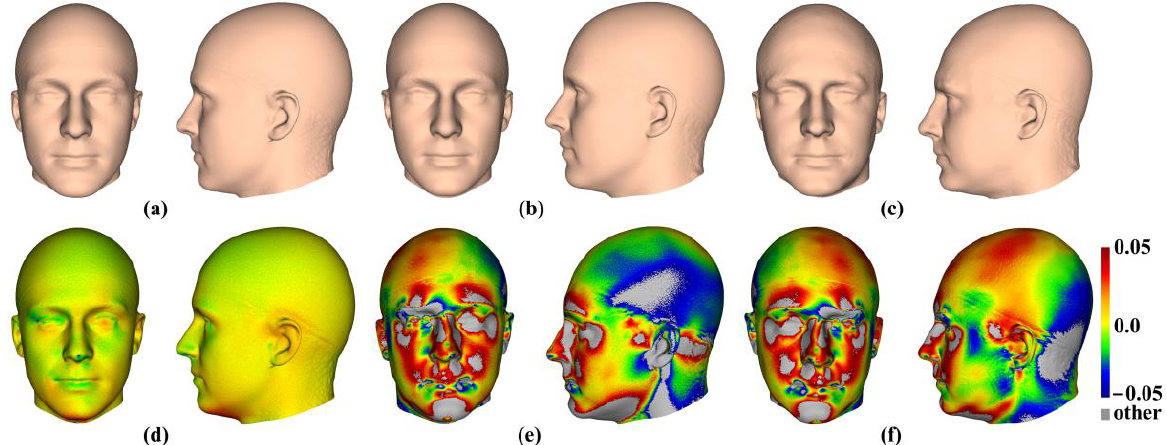
Figure 23. ( a ) Mean head surface estimated by warping the template surface to the mean configuration of landmarks and 1000 semilandmarks from sliding TPS. ( b ) Mean head surface estimated by warping the template surface to the mean landmark configuration. ( c ) Mean head surface estimated by warping the surface of the head with minimum Procrustes distance from the mean to the mean landmark configuration. ( d ) Colour map between surfaces a (reference) and b (target). ( e ) Colour map between surfaces a (reference) and c (target). ( f ) Colour map between surfaces b (reference) and c (target).